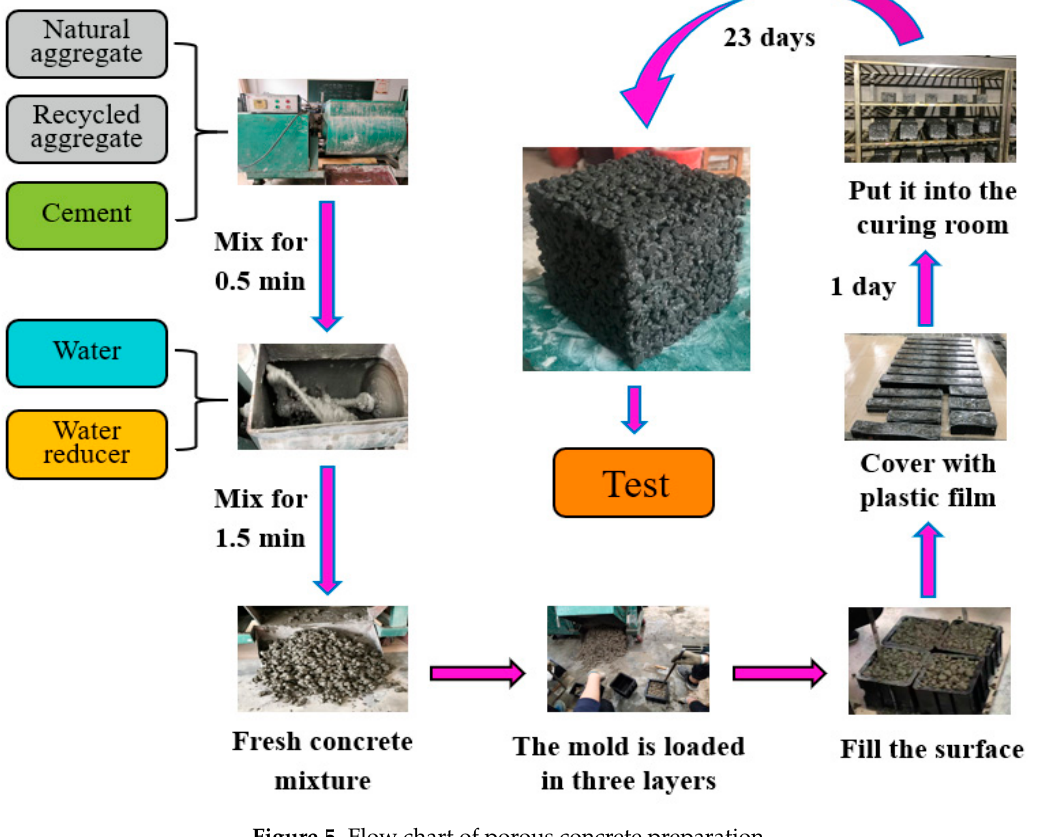
Figure 5. Flow chart of porous concrete preparation.